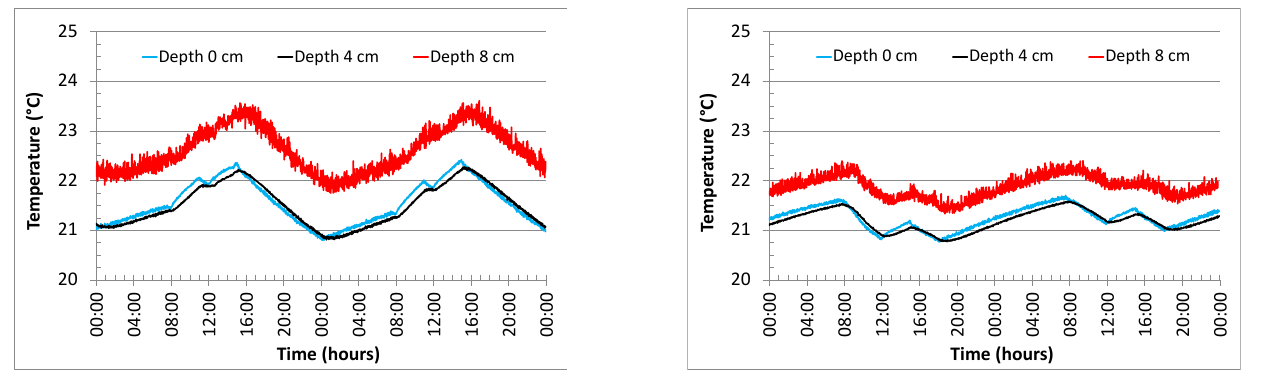
scenarios. The discharging occurred in non-occupancy periods when the airflow to the test setup was reduced to zero. Throughout the experiment, temperatures at 8 cm depth remain noticeably higher than the temperatures at 0 and 4 cm depths.